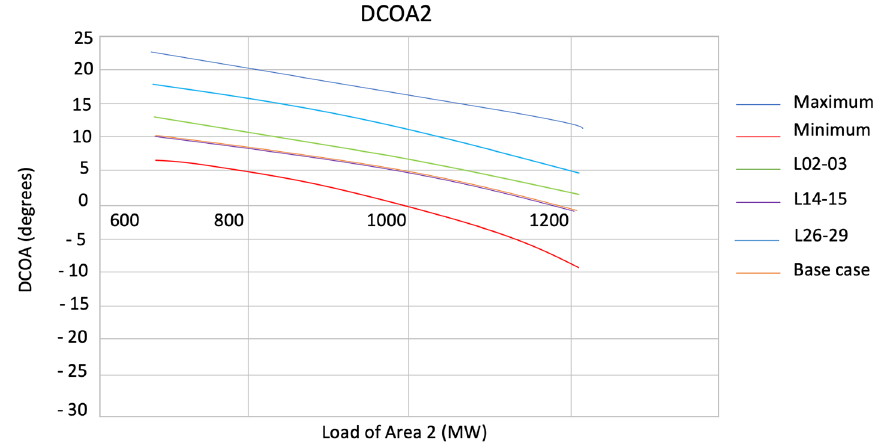
Figure 11. Angular characterization for contingencies N-1 in operational area 2.